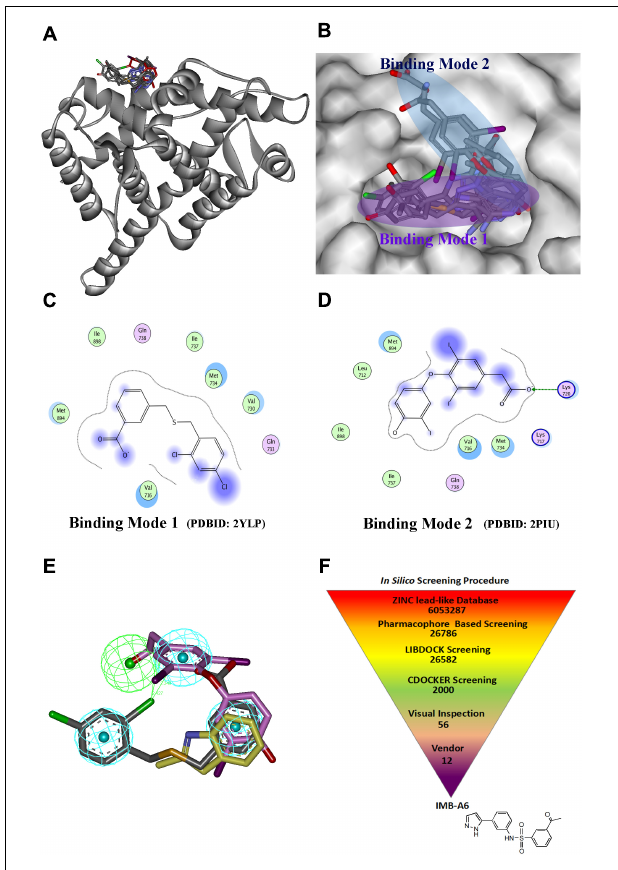
FIGURE 1 | The structural virtual screen targeting the AF2 site of AR. (A) The alignment of the structures with ligand binding to AF2 site. (B) The ligands binding to the AF2 site adopt two different binding modes. (C) The representative for the binding mode 1. (D) The representative for the binding mode 2. (E) The generating combining binding mode. (F) In silico screening